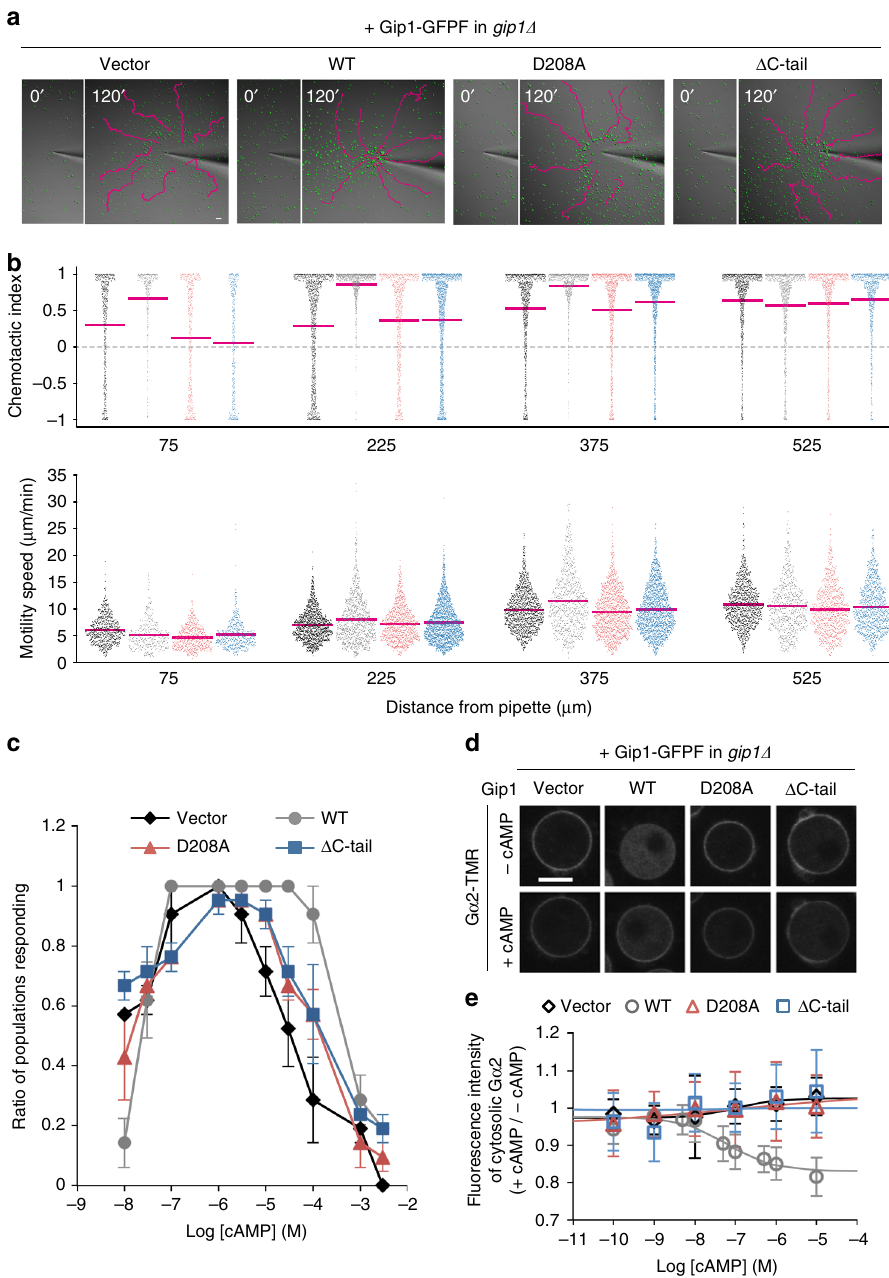
Fig. 7 Contribution of Gip1 – G protein complex formation to wide-range chemotaxis. a Chemotaxis of gip1 Δ cells expressing Gip1 mutants. Cells (green) moved towards the tip of a micropipette fi lled with 100 μ M cAMP. Representative images with cell trajectories (magenta lines) are shown before (0 ′ ) and 120 min after (120 ′ ) the start of the assay (see Supplementary Movies 3 – 6). Scale bar, 50 μ m. b Chemotactic index (top) and motility speed (bottom) calculated from the assay in a . The magenta lines represent the mean ( n = 285 – 1737 data points from at least 103 cells). Vector, WT, D208A, and Δ C-tail are shown in black, grey, red, and blue, respectively. c Chemotactic response to various cAMP concentrations. The data represent the mean ± SEM of three independent experiments. Vector, WT, D208A, and Δ C-tail are shown by the black- fi lled diamond, grey- fi lled circle, red- fi lled triangle, and blue- fi lled square, respectively. d G α 2 translocation upon cAMP stimulation in the presence of LatA. Images are from before ( − cAMP) and after ( + cAMP) 10 μ M cAMP application. Scale bar, 5 μ m. e Dose dependency of G α 2 translocation in response to different cAMP concentrations. The data represent the mean ± SD ( n ≥ 60 cells). Vector, WT, D208A, and Δ C-tail are shown by the black-open diamond, grey-open circle, red-open triangle, and blue-open